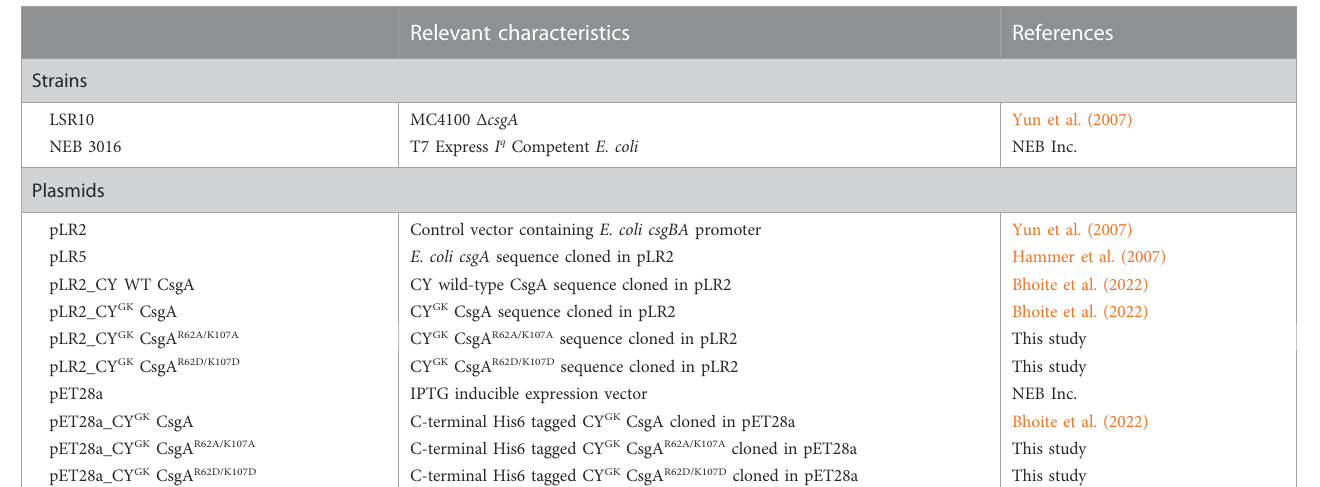
TABLE 3 Strains and plasmids used in this